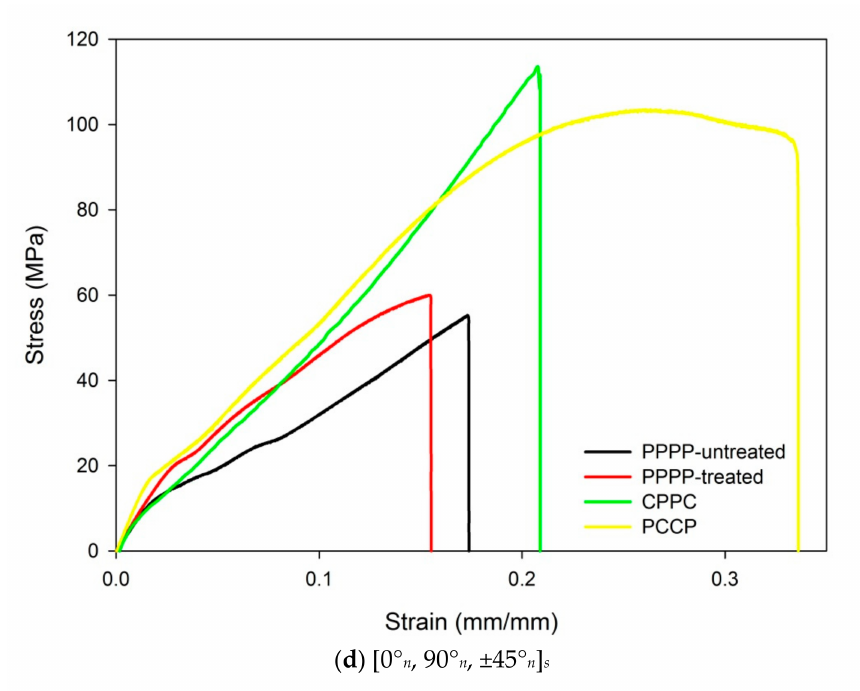
Figure 2. Tensile stress-strain behaviour of PALF/carbon hybrid laminate composites with different material stacking sequences: ( a ) [0 ◦ , 90 ◦ ] n , ( b ) [ ± 45 ◦ ] n , ( c ) [ ± 45 ◦ n , 0 ◦ n , 90 ◦ n ] s and ( d ) [0 ◦ n , 90 ◦ n , ± 45 ◦ n ] s